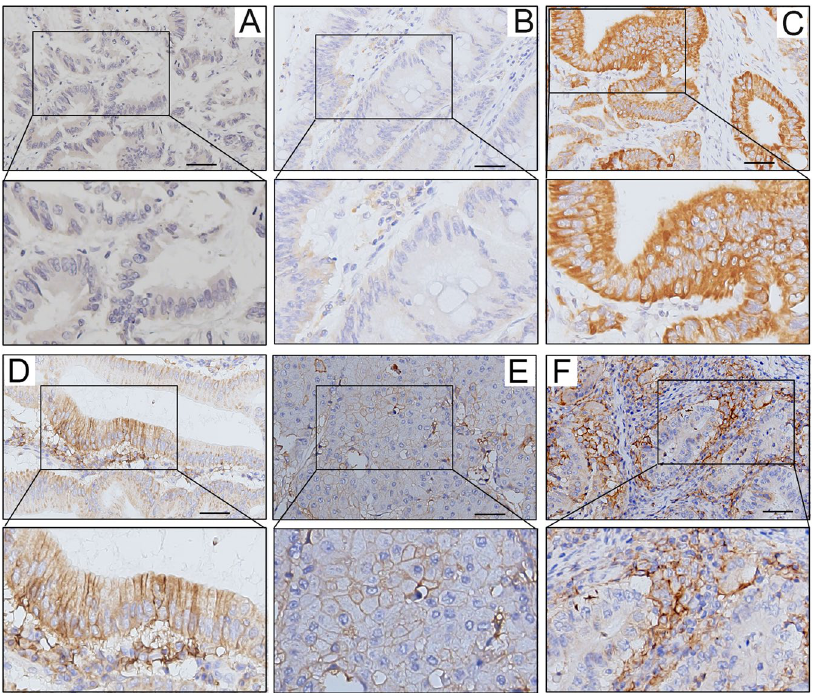
Figure 1. Expression patterns of tumor CD274 (PD-L1) within the tumor microenvironment of colon carcinoma. ( A ) Negative CD274 immunohistochemical staining within the tumor microenvironment. ( B ) Weak cytoplasmic CD274 expression. ( C ) Strong positive cytoplasmic CD274 expression. ( D ) Weak cytoplasmic and positive membranous CD274 expression in patients with adenocarcinoma. ( E ) Moderate positive